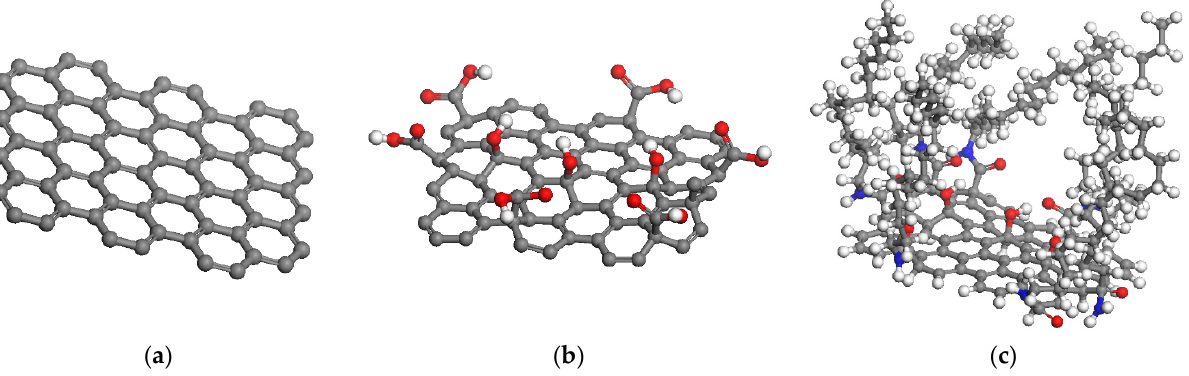
Figure 3. Modified graphene oxide conformation (gray—carbon atoms; red—oxygen atoms; white —hydrogen atoms; blue—nitrogen atoms): ( a ) Thin layer of carbon; ( b ) GO; ( c ) NGOs.